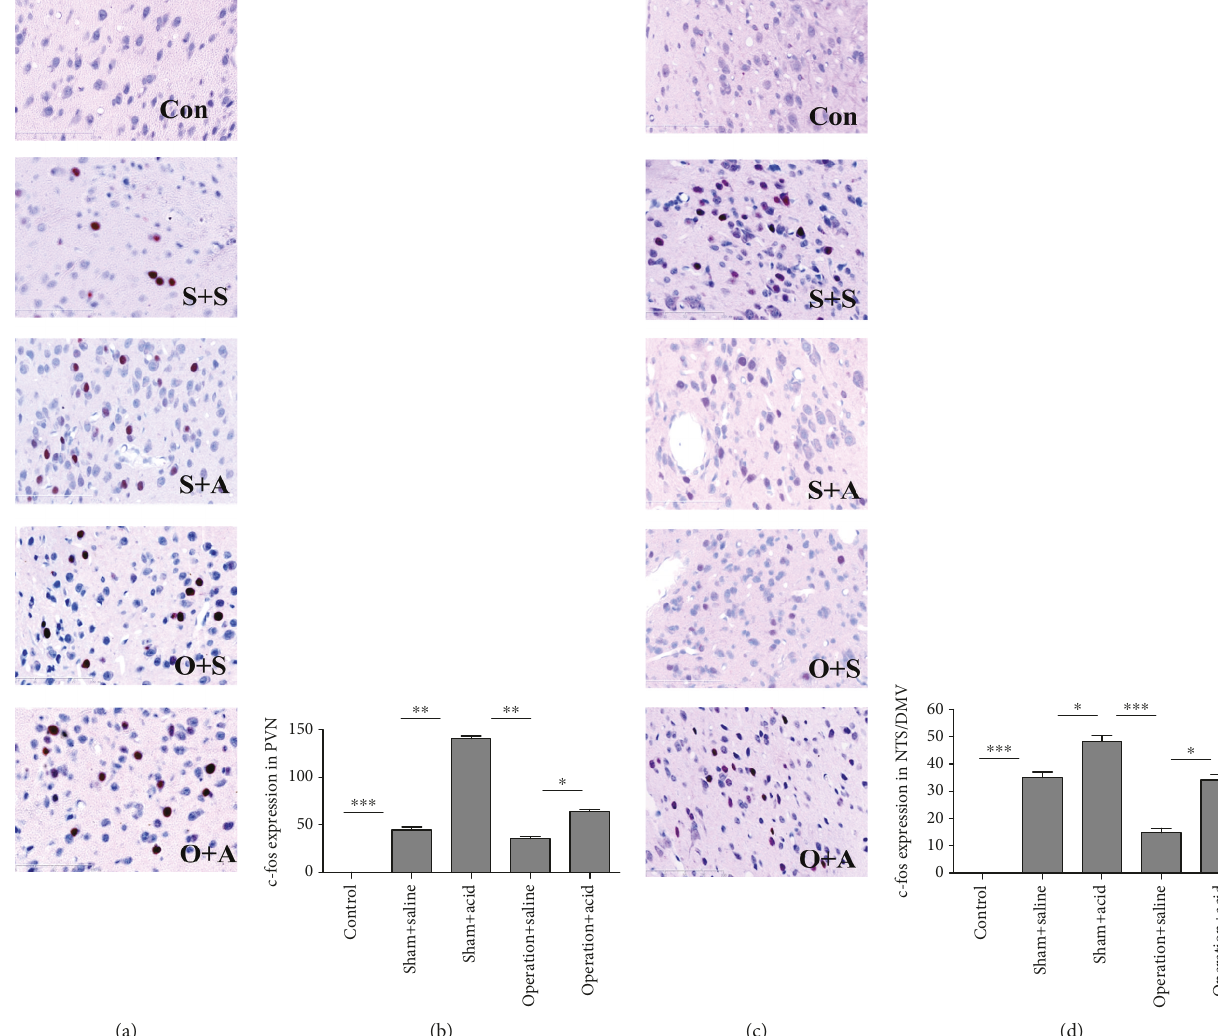
Figure 5: DMV destruction downregulated c-fos expression in the PVN and the NTS/DMV. (a) c-fos-positive cells with red nuclei in the PVN in the di ff erent groups. ( × 400). (b) Induction of c-fos expression in the PVN by esophageal instillation and DMV destruction. c-fos expression in the PVN increased more signi fi cantly in the sham + acid group than in the sham + saline group ( P < 0 01 ). After DMV destruction, c-fos expression more signi fi cantly decreased in the PVN in the operation + saline group than in the sham + acid group ( P < 0 01 ). c-fos expression was higher in the PVN in the operation + acid group than in the operation + saline group ( P < 0 05 ). (c) c-fos-positive cells with red nuclei in the NTS/DMV in the di ff erent groups ( × 400). (d) Induction of c-fos expression in the NTS/DMV by esophageal instillation and DMV destruction. c-fos expression in the NTS/DMV increased more in the sham + acid group than in the sham + saline group ( P < 0 05 ). After DMV destruction, c-fos expression more signi fi cantly decreased in the NTS/DMV in the operation + saline group than in the sham + acid group ( P < 0 001 ). c-fos expression was higher in the NTS/DMV in the operation + acid group than in the operation + saline group ( P < 0 05 ) (Con: control group; S+S: sham + saline group; S+A: sham + acid group; O+S: operation + saline group; O+A: operation + acid group. n = 8 , ∗ P < 0 05 , ∗∗ P < 0 01 , ∗∗∗ P < 0 001